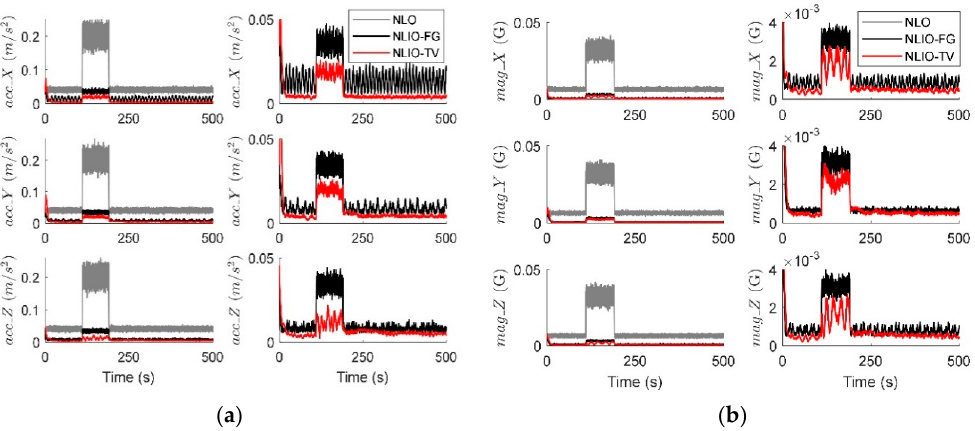
Figure 9. Averaged absolute vector measurement estimation errors over 100 simulations for Case 3. ( a ) Accelerometer measurement estimation errors evaluated by the auxiliary observers of the NLO and NLIOs. ( b ) Magnetometer measurement estimation errors evaluated by the auxiliary observers of the NLO and NLIOs.